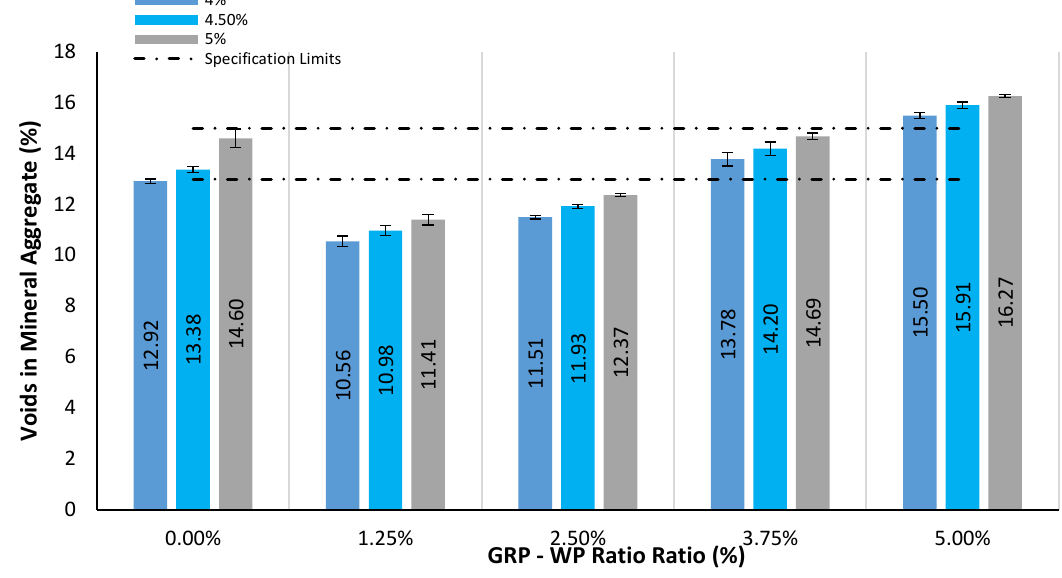
Figure 6. Comparison of VMA results for the 45 samples tested.